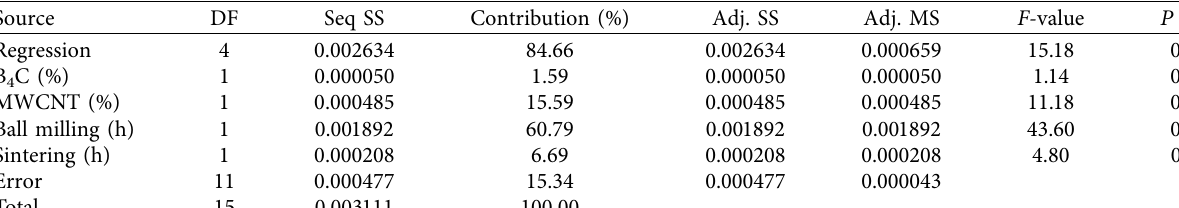
Table 6: Analysis of variance for wear analysis.